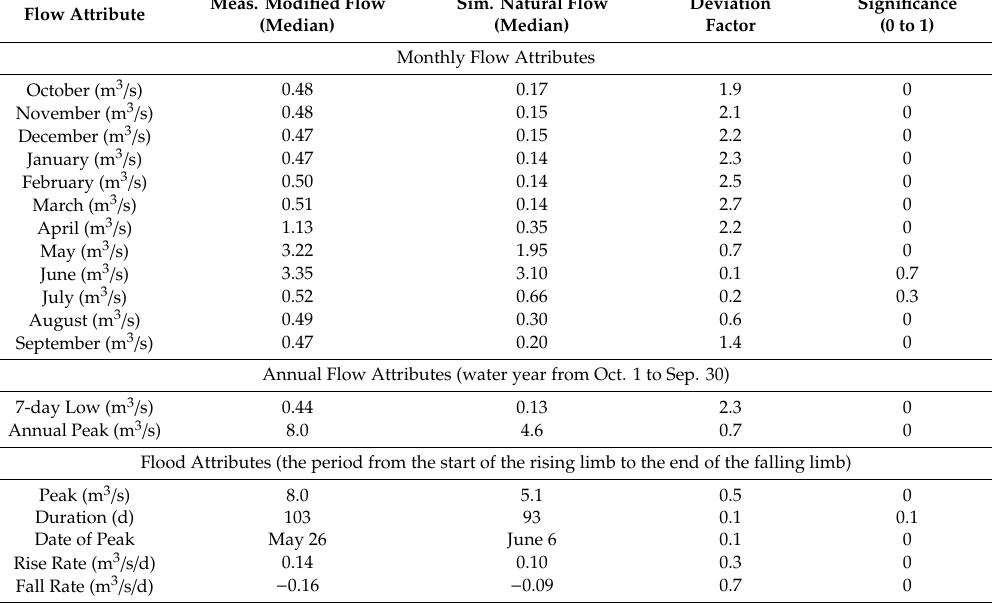
Figure 4. Simulated natural and measured modified ( a ) daily mean and ( b ) cumulative daily average flows for the study watershed for the subset of the time period shown in Figure 3. Table 3. Comparison of the simulated natural and measured modified flow attributes to assess the degree of alteration using a deviation factor and the significance of the alteration, ranging from highly significant (0) to not significant (1).